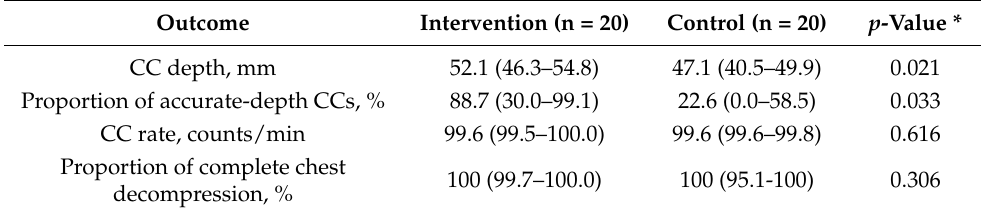
Table 2. Outcome of chest compressions conducted between the intervention and control. Outcome Intervention (n = 20) Control (n = 20) Proportion of accurate-depth CCs, %